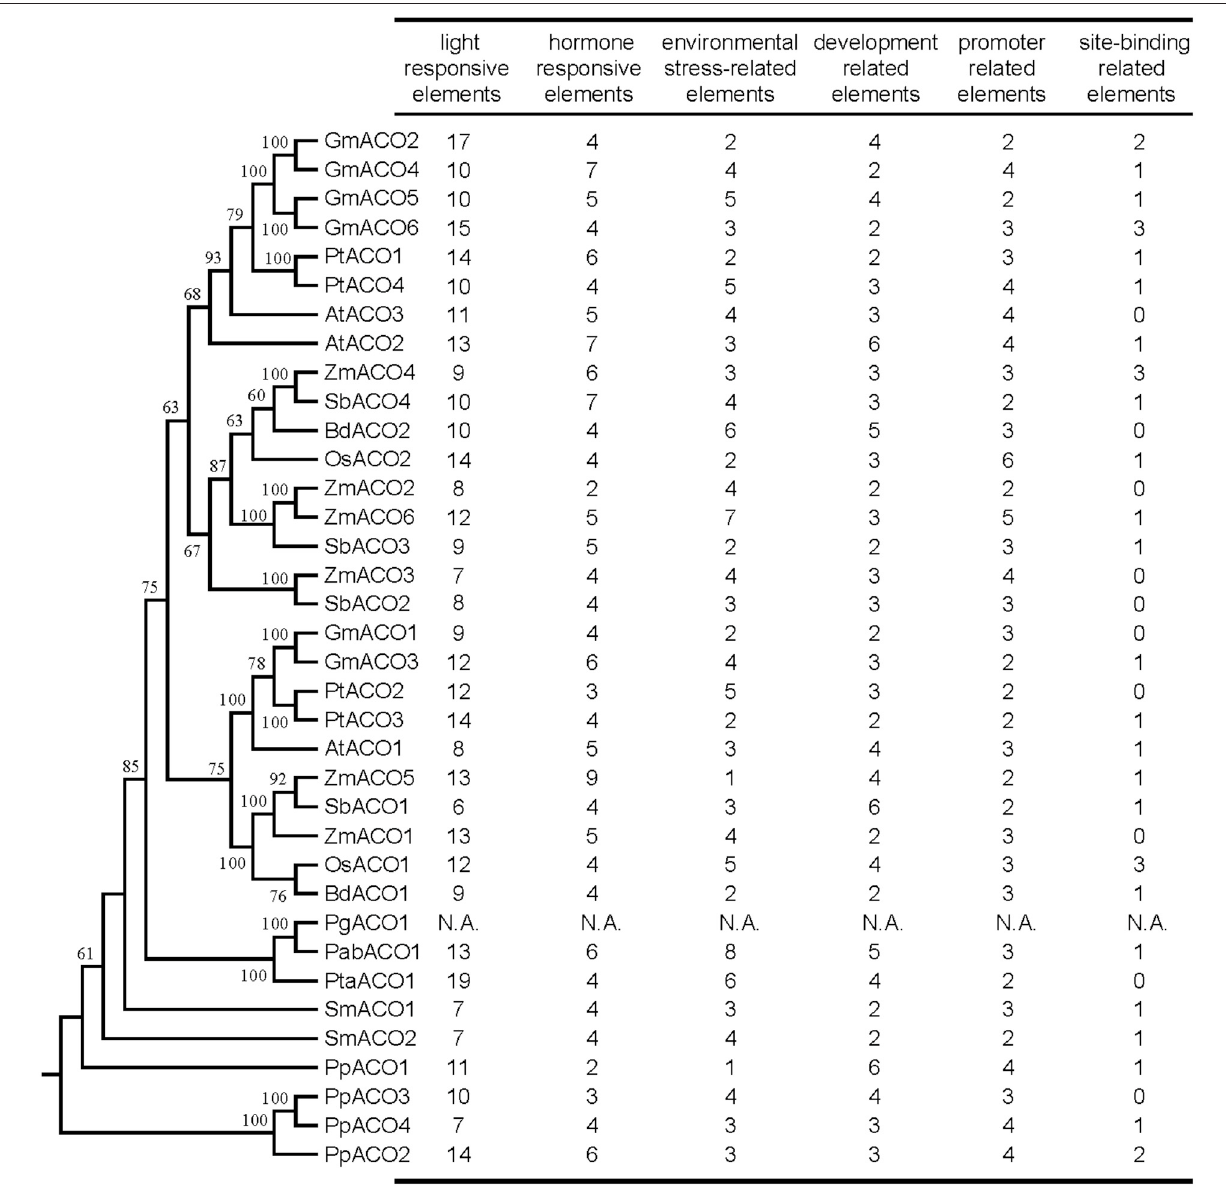
might participate in light regulatory pathways. Additionally, promoters of ACO genes that also harbored cis -acting elements responded to phytohormones such as methyl jasmonate (MeJA), abscisic acid (ABA), auxin, ethylene, salicylic acid (SA), and gibberellin. We found that each promoter region of ACO genes in the angiosperm A2 clade ( Figure 3 ) contained two cis -acting elements responding to MeJA, whereas the promoter regions of three ACO genes ( OsACO2 , SbACO2 , and ZmACO2 ) in angiosperm clade A1 did not ( Figure 3 ). These results indicate that plant ACOs may play a role in phytohormone